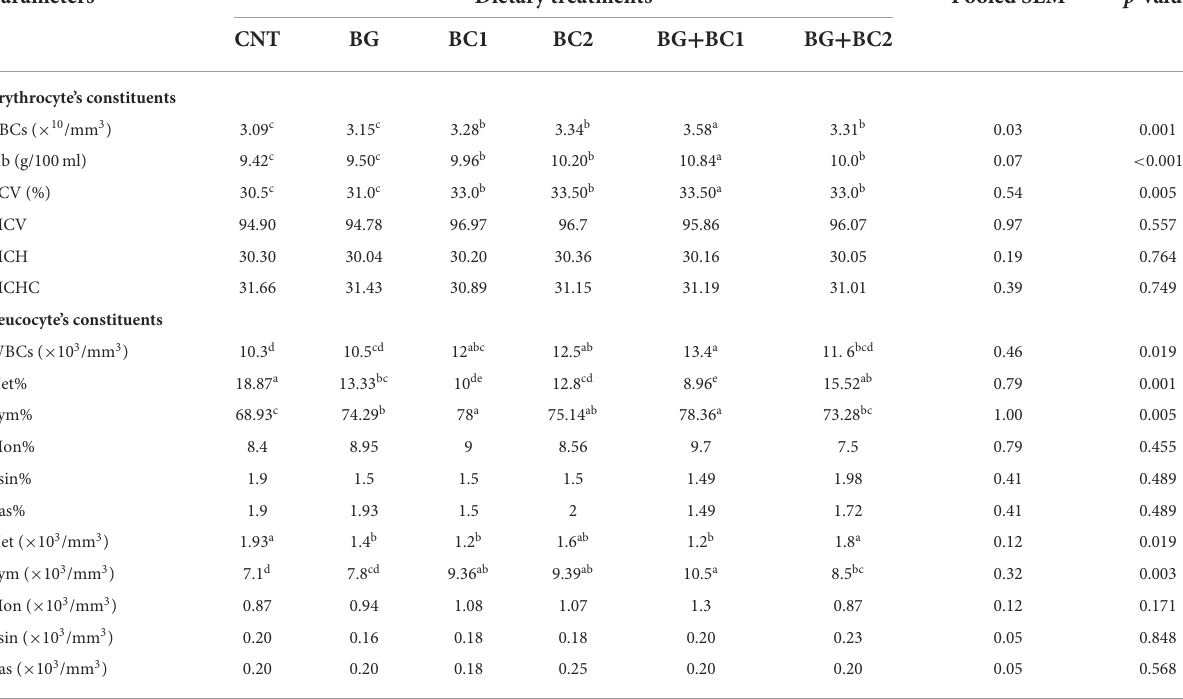
TABLE 5 Effects of dietary supplementation with β -glucan and/or Bacillus coagulans on blood hematological measurements of tilapia fish. Parameters Dietary treatments Pooled